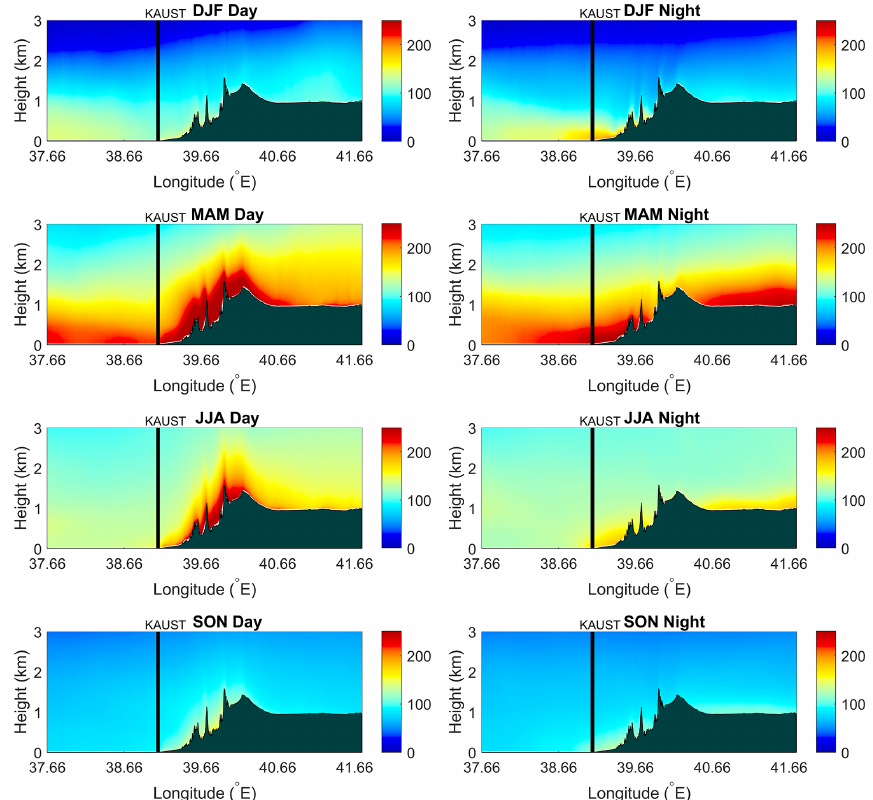
Figure 16. Longitudinal cross section, perpendicular to the coastline, of aerosol concentrations (µgm − 3 ) over KAUST. Data are averaged seasonally and presented separately for the day (left column) and night (right column). Data averaged during the same period as in Fig. 15 to demonstrate the effect of land and sea breezes on dust aerosols. The vertical line in black shows the location of the KAUST site. The land profile along the same section is depicted in black shades, the top of which shows the actual land